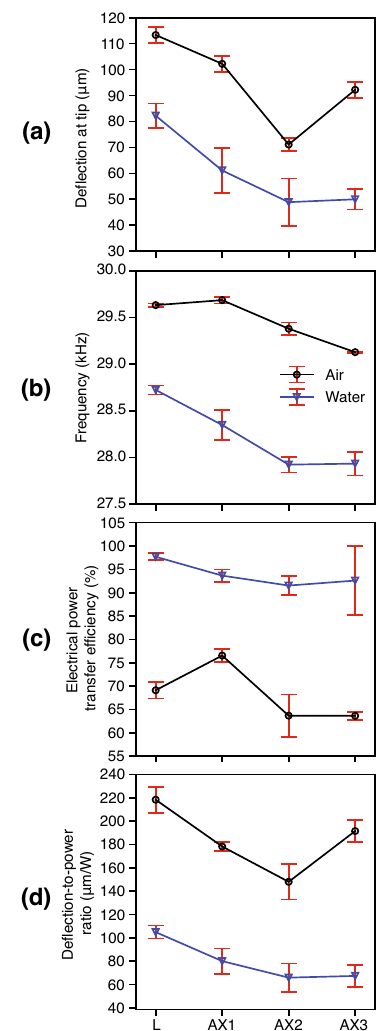
Figure 12. Measured flexural-deflection magnitudes of needle tip (mean ± s.d., n = 5) of bevels L and AX1–3 in air and water (20 mm depth), revealed the effects of changing bevel geometry. Measurements were obtained using continuous single-frequency sinusoid excitation. ( a ) Peak-to-peak deflection ( u y (cid:31) j ) at the tip-point, measured at ( b ) their respective modal frequencies f 2 . ( c ) The electrical power transfer efficiency (PTE, r.m.s., %) as in Eq. (4), and ( d ) the deflection-to-power ratio (DPR, µm/W), which was calculated as the ratio of the peak-to-peak deflection over the transmitted electrical power P T (W, r.m.s.).